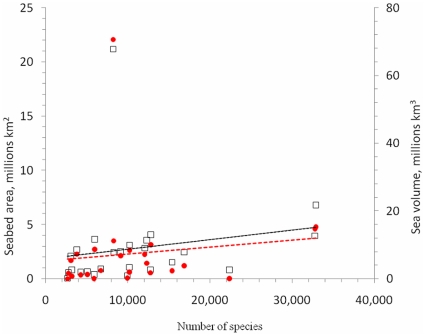
The relationship between total number of recorded species in each region to sea volume (solid red dots, dashed line, millions km3), and seabed area (squares, solid line, millions of km2) with linear trend lines shown.